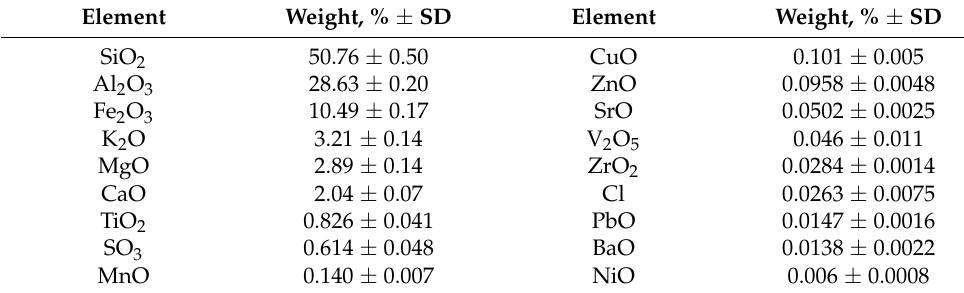
Table 3. XRF data of chemical compositions of